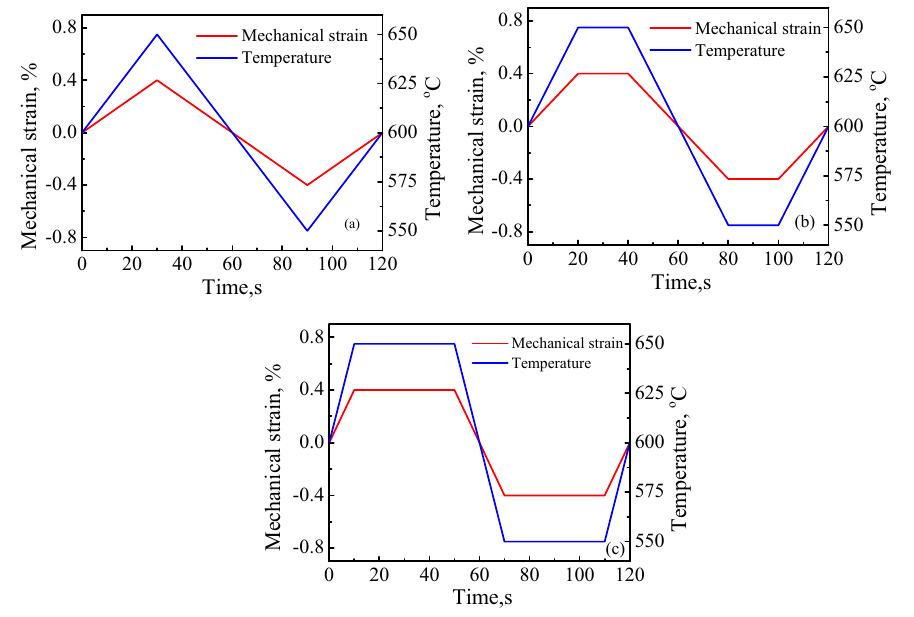
Figure 2: TMF test waveforms: ( a ) IP 0 s, ( b ) IP 20 s, and ( c ) IP 40 s.